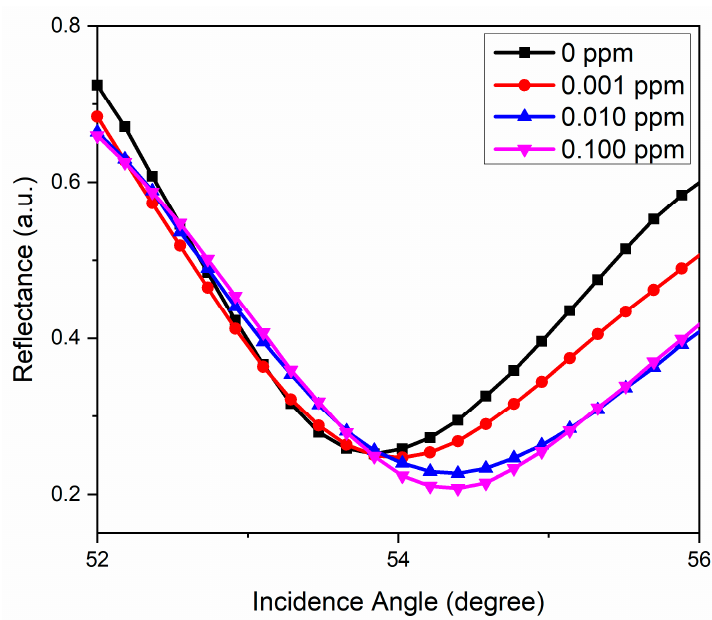
Figure 9. Reflectance as a function of the incidence angle for deionized water and various concentrations of mercury ion solution.